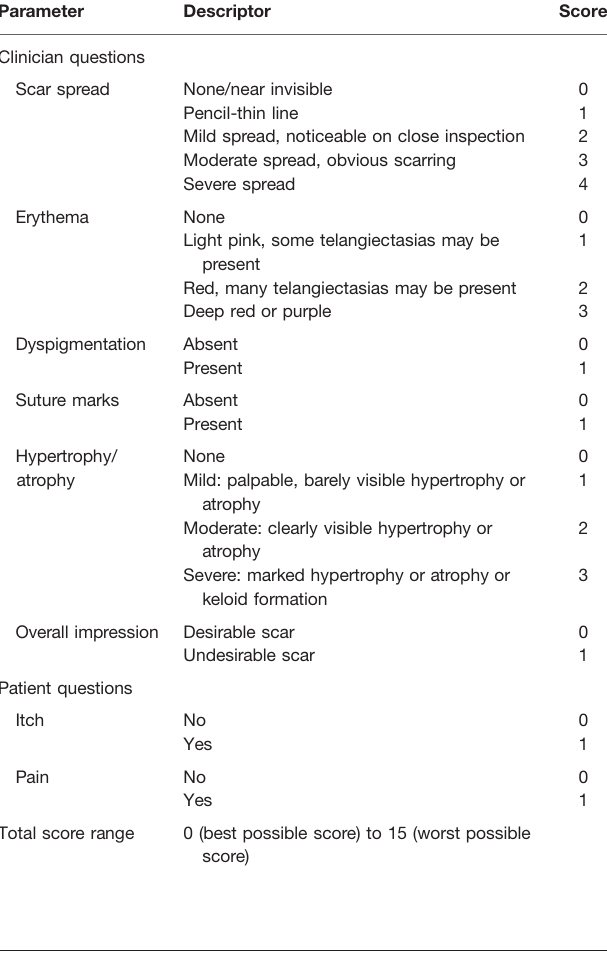
TABLE 3 | The Scar Cosmesis Assessment and Rating (SCAR) scale